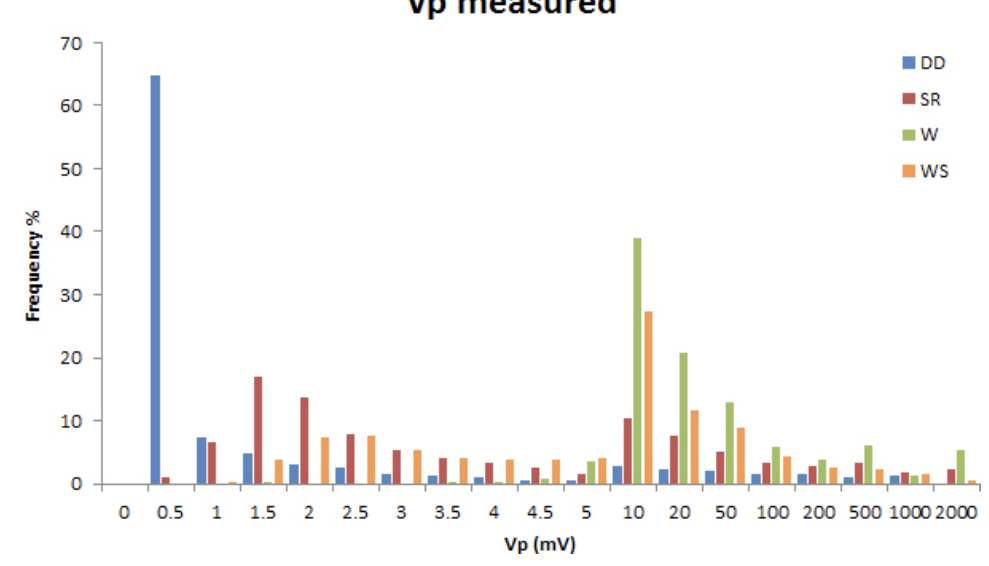
Figure 8. Frequency distribution of measured voltage for each of the tested configuration. Dipole– Dipole (DD), Schlumberger Reciprocal (SR), Wenner (W) and Wenner–Schlumberger (WS). Table 1. Root-mean squared error (RMS) values of the inversion of data acquired with the four different quadripolar